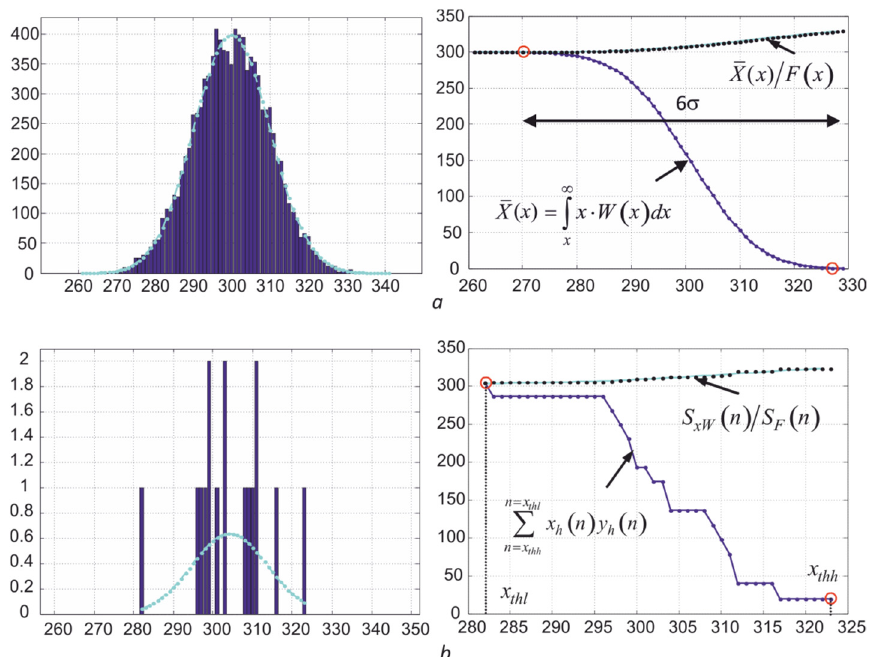
∗ ∗ on the values of the on the values of the (cid:12) (cid:12)(cid:0) (cid:12) (cid:1) (cid:1) (cid:0) D thl − D D thh − D / σ / σ (cid:12) , and k h =